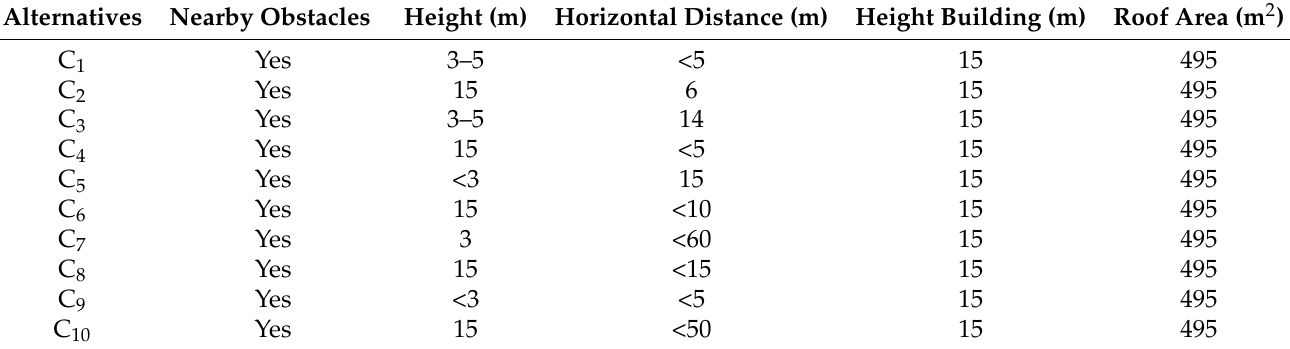
Table 5. Alternatives of the typology of turbines on the roofs of buildings. Urban